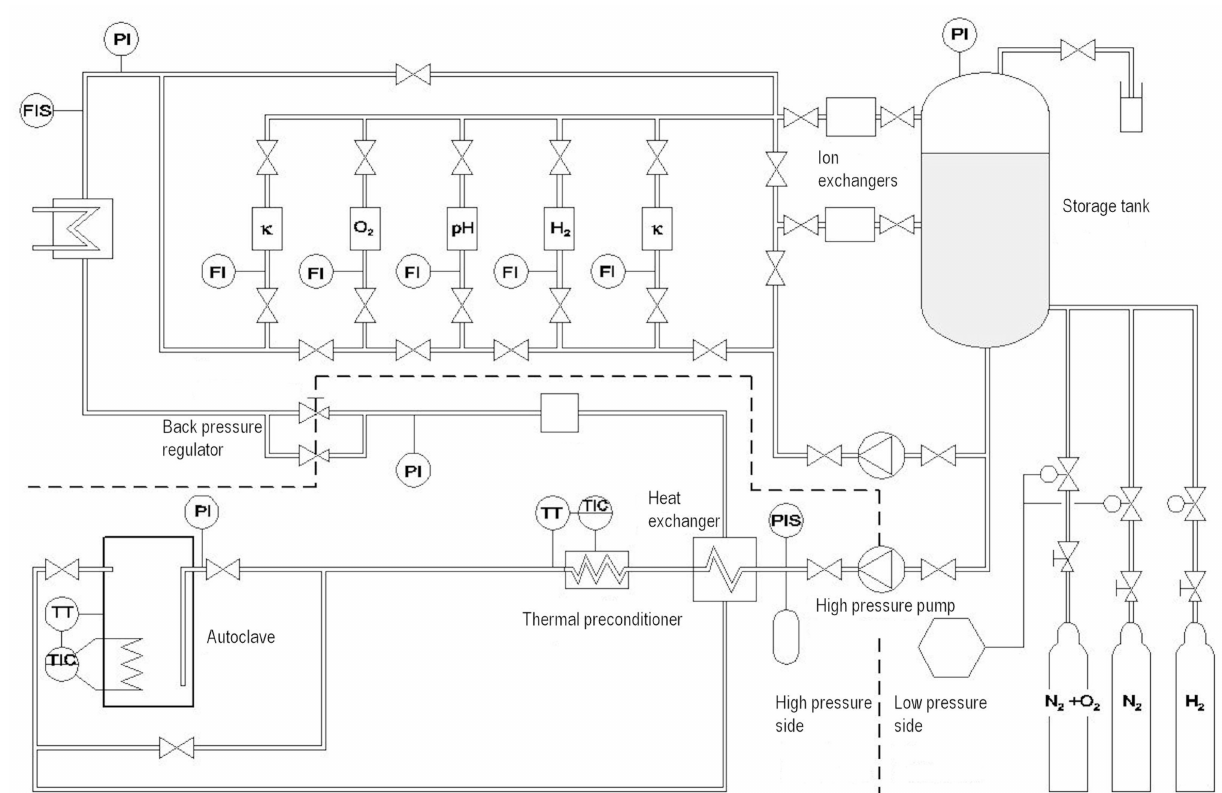
Figure 6. A schematic presentation of the high-temperature recirculation loop used in the auto-clave experiments. The functionality test aimed at: (1) measuring the stability of test parameters at a typical test temperature of ~300 ◦ C and (2) reaching a higher typical test temperature (340 ◦ C) without leaks or cooling problems. The minimum, maximum, and average